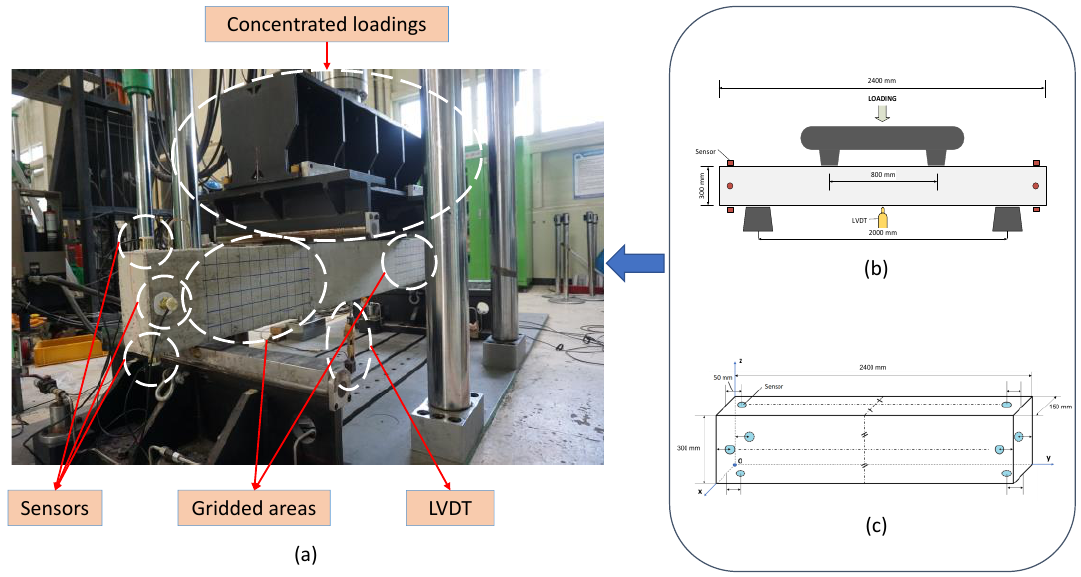
Figure 3. Experimental setup of the four-point bending test on reinforced concrete beam: ( a ) pictorial of the specimen under test, ( b ) schematic of the four-point bending arrangement, and ( c ) placement of sensors on the